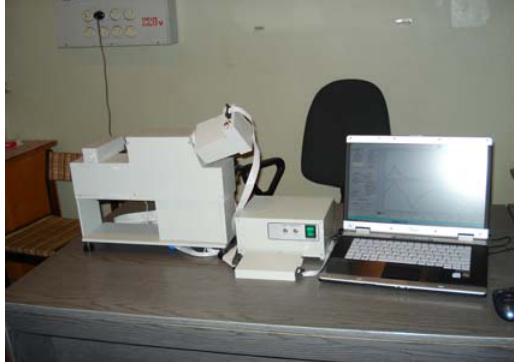
Figure 1. High precision real-time Multi-channel spectrellipsometer .